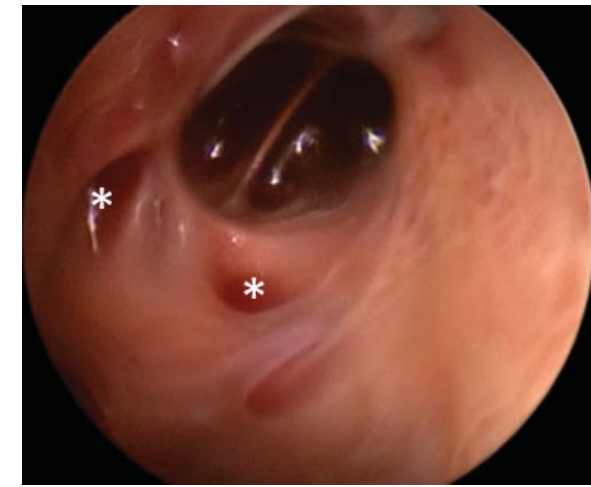
Fig. 2 Intraoperative image showing a macrocystic cavity and many small fl uid- fi lled cysts (asterisks), which are separated by thin